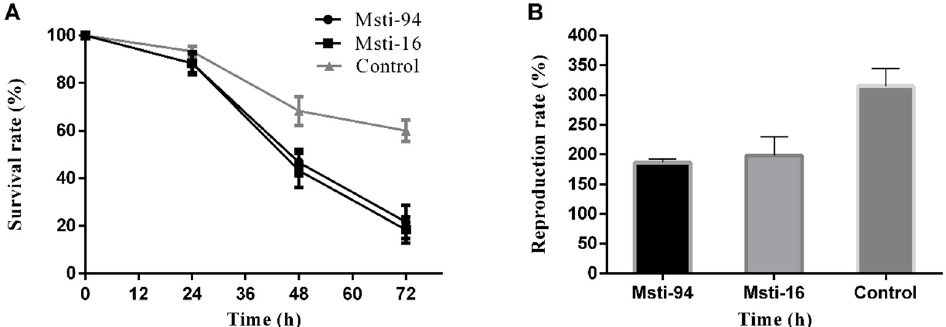
Figure 6. Control had artificial feed without any inhibitors (non-induced bacterial sample) ( A ) The survival rate of aphids fed for 72 h with Msti, with a treated dose of 800 μ g/mL purified protein; ( B ) reproduction rate of aphids fed for 72 h with Msti, with a treated dose of 800 μ g/mL purified protein. The reproduction rate of the aphids was higher than 100% because of parthenogenesis and overlapping generations.